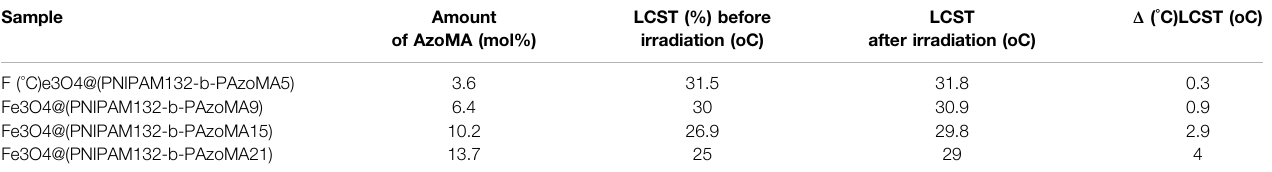
TABLE 1 | Summarized data on Fe3O4@PNIPAM-b-PAzoMA. Sample Amount